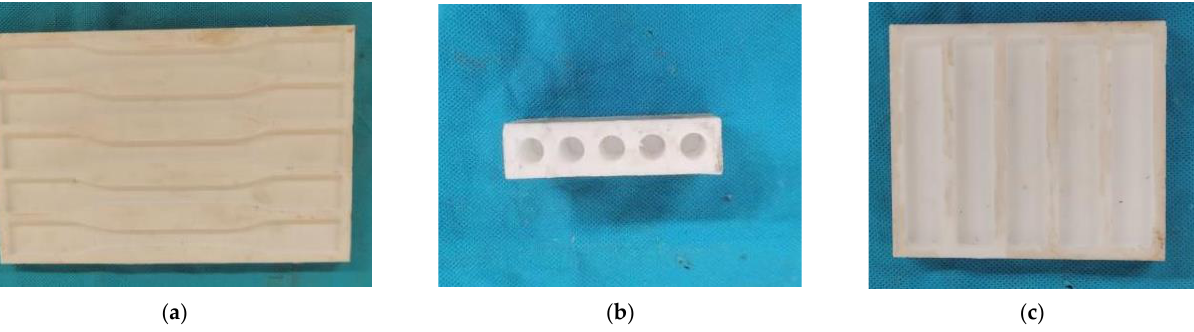
Figure 2. Epoxy resin and epoxy resin mortar specimen molds. ( a ) Tensile specimen mold; ( b ) compression specimen mold; ( c ) bending specimen mold.